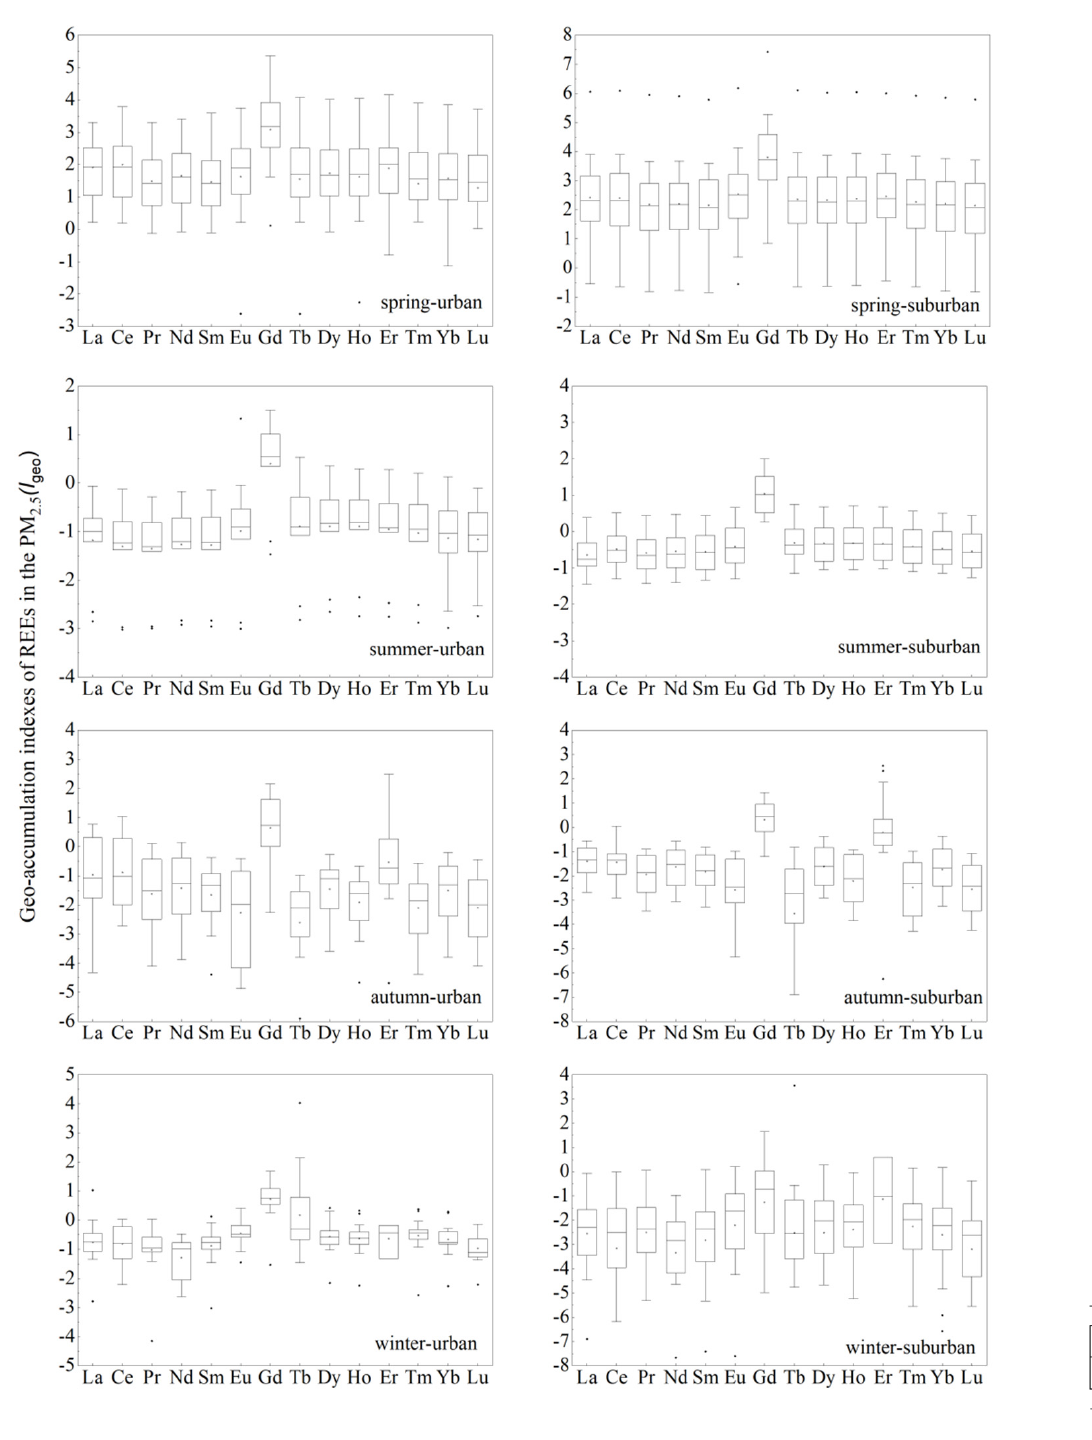
Figure 2. The I geo values of REEs in PM 2.5 in Xiamen.